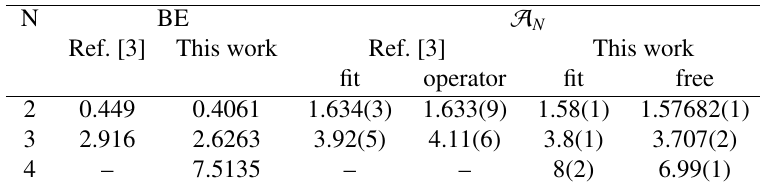
Table 1. Binding energies (in natural units) and dimensionless ANCs for the bosonic case, from Ref. [3] and as calculated here. ANCs are calculated by fitting the energy shifts in a box (fit), by the expectation value of a short-range operator (operator), and deduced directly from the free-space wave function